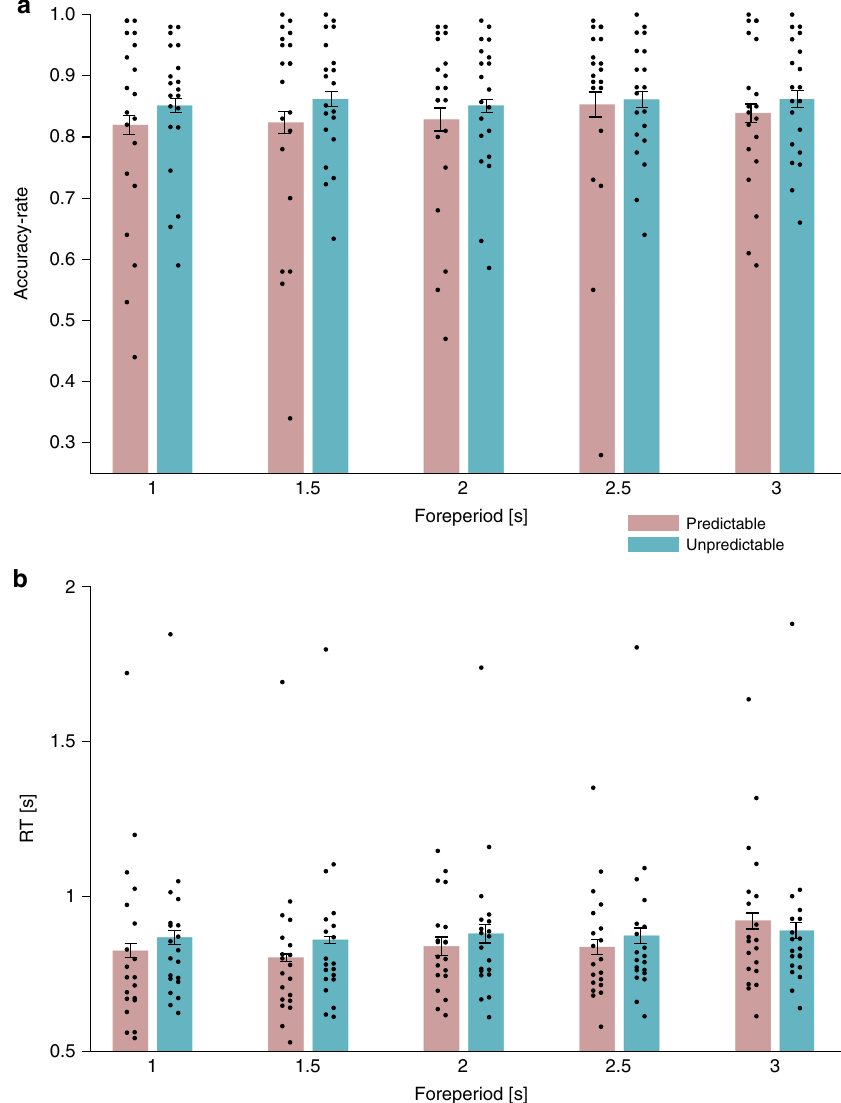
Fig. 2 Accuracy-rates and reaction times (RTs) by predictability and foreperiod. a Accuracy-rates in predictable (pink bars) and unpredictable (turquoise bars) conditions. N = 20 participants. b Reaction times in predictable (pink bars) and unpredictable (turquoise bars) conditions. Error bars denote ±1 standard error of the mean, corrected for within-subjects variability 60 . N = 20 participants. Source data are provided as a Source Data fi